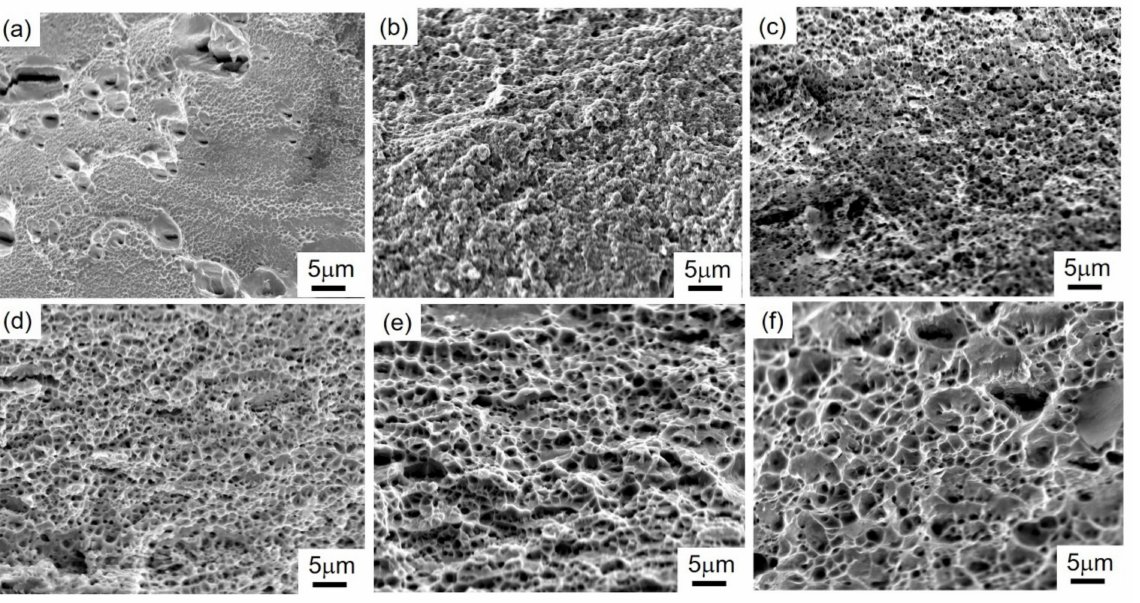
Figure 9. Fracture surface of the annealed UFG 316LN steels: ( a ) HPT-5N; ( b ) 700 ◦ C annealing; ( c ) 750 ◦ C annealing; ( d ) 800 ◦ C annealing; ( e ) 850 ◦ C annealing; ( f ) 900 ◦ C